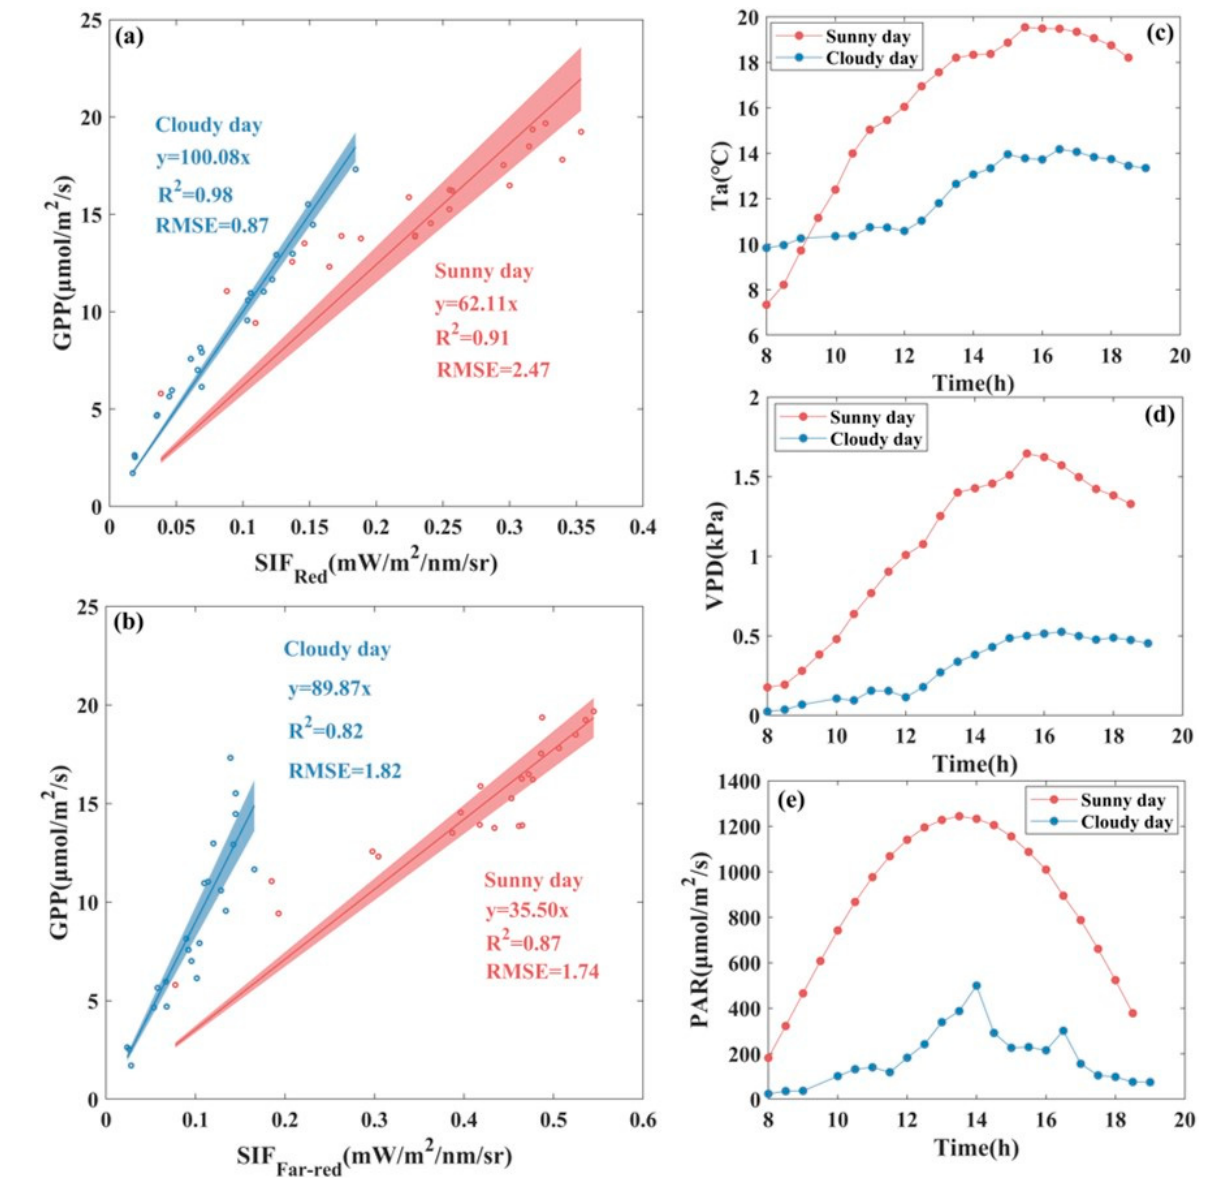
Figure 6. Scatter plot of the fitted relationship between ( a ) SIF Red , ( b ) SIF Far-red , and GPP at the diurnal scale and daily variations of ( c ) air temperature (Ta), ( d ) vapor pressure deficit (VPD), and ( e ) photosynthetically active radiation (PAR) for a typical sunny day and cloudy day at AR site. The scatter points represent half-hourly averaged data, the solid line represents the fitted line of the SIF-GPP relationship, and the shaded area indicates the 95% confidence level of the prediction, where red represents sunny day and blue represents cloudy day.